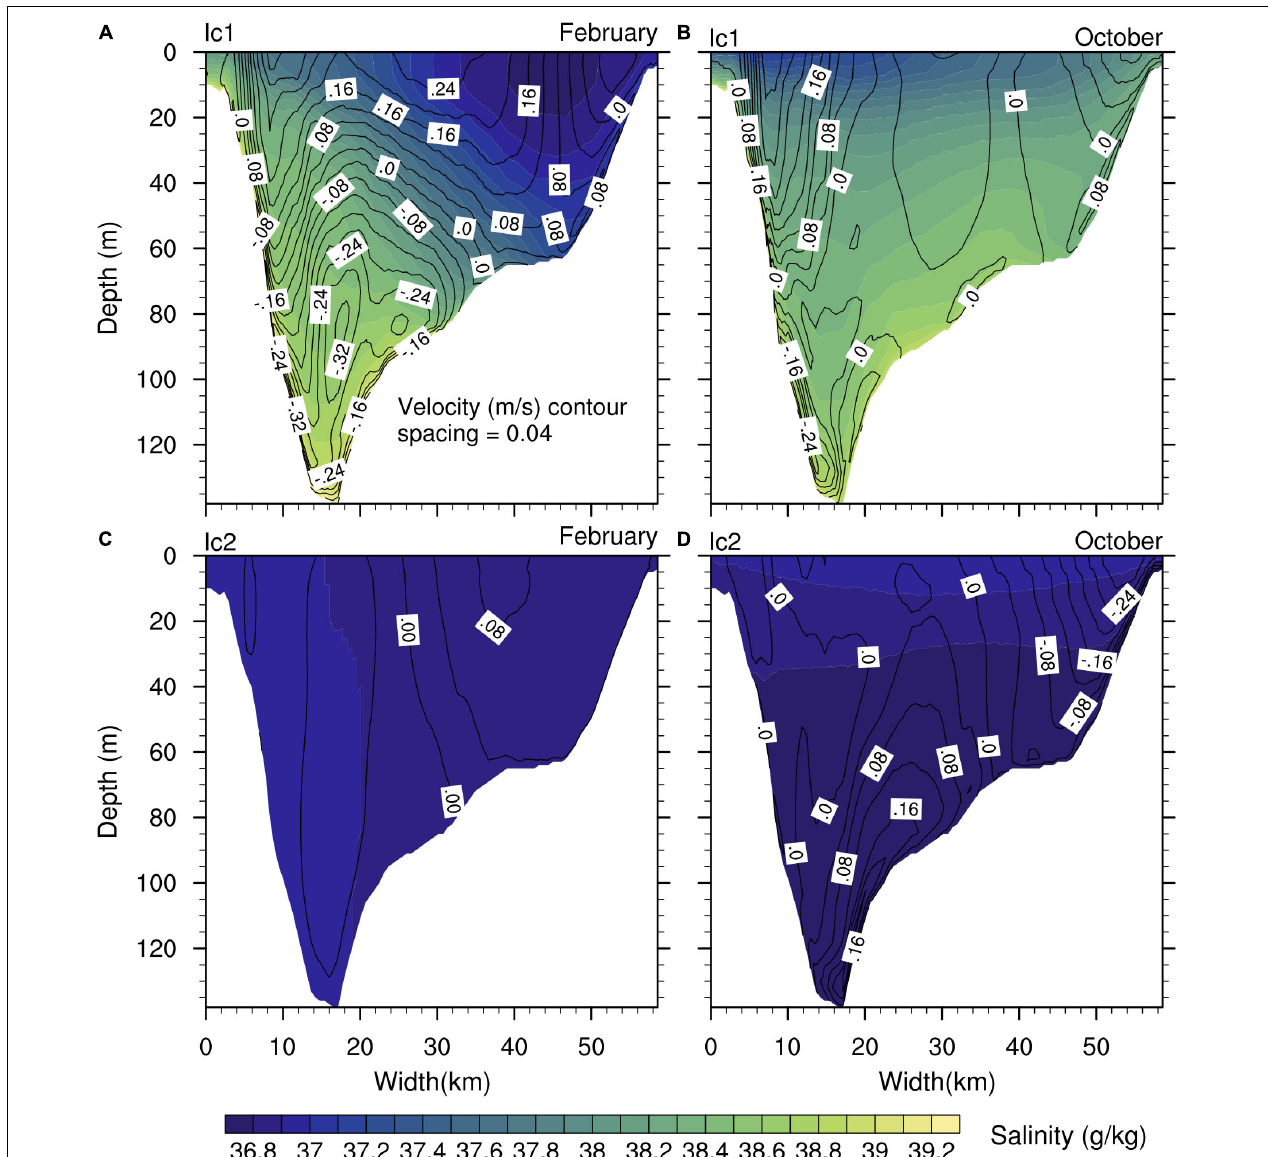
FIGURE 6 | Simulated climatological February and October salinity and net lateral velocity (velocity in minus velocity out) into (positive) and out (negative) of the Gulf at the Strait of Hormuz in the overturning circulations associated with: Ic1 equilibrium (A,B) and Ic2 equilibrium (C,D) ; colored contour is salinity and line contour is net lateral